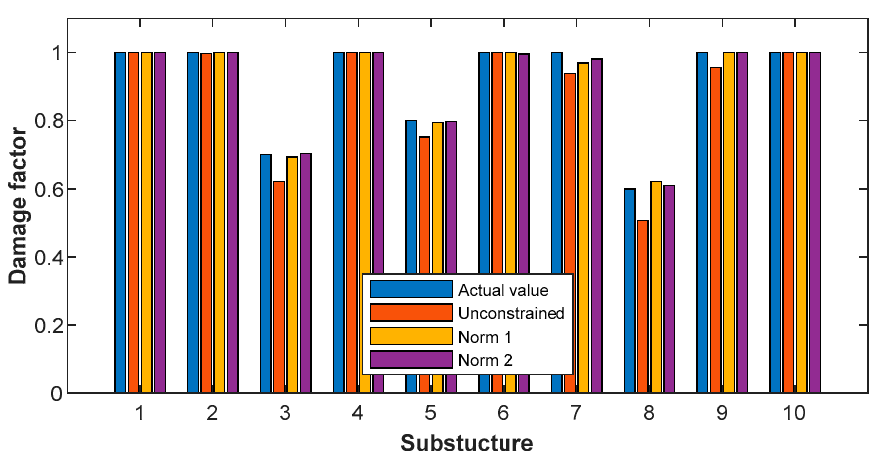
Figure 4. Identification results of Lasso regression model with l 1 norm and ridge regression model with l 2 norm.